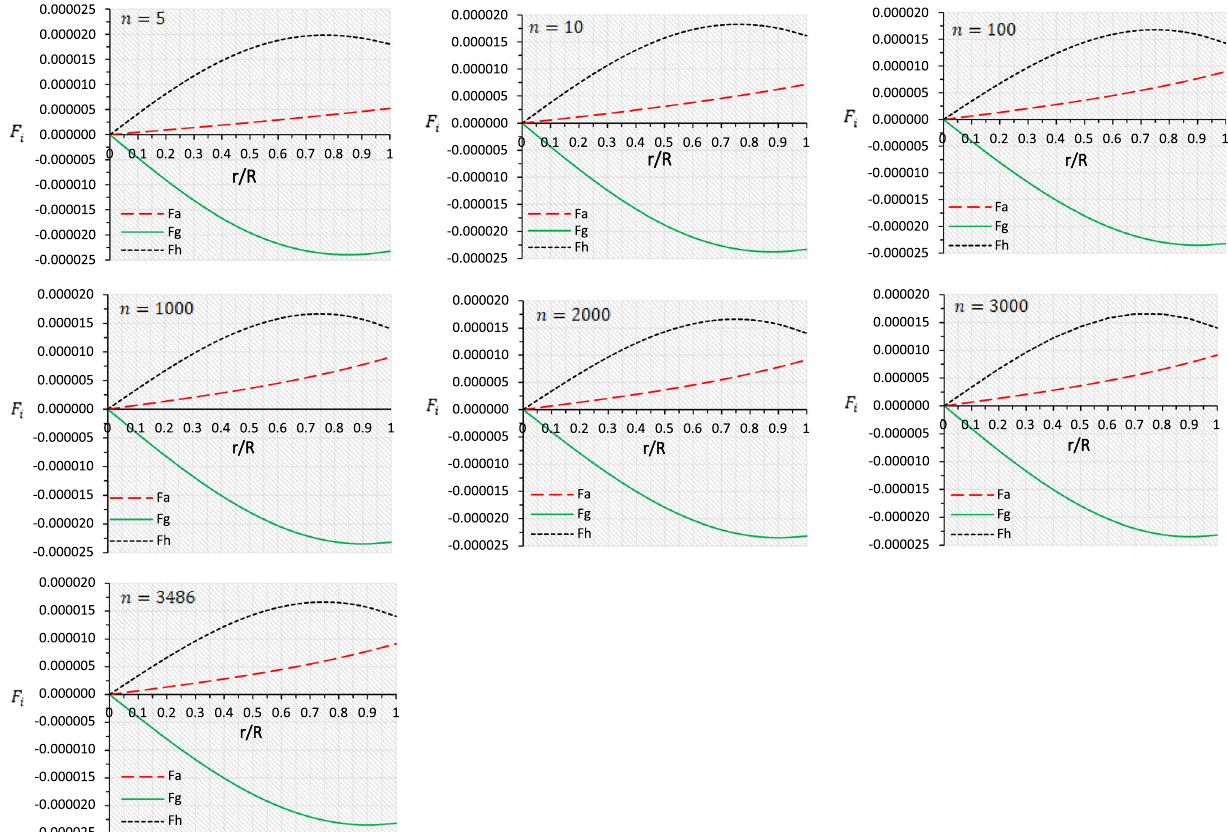
Fig. 8 Behaviour of different forces F g , F h and F a vs. radial coordinate r / R with different values of n for LMC X − 4